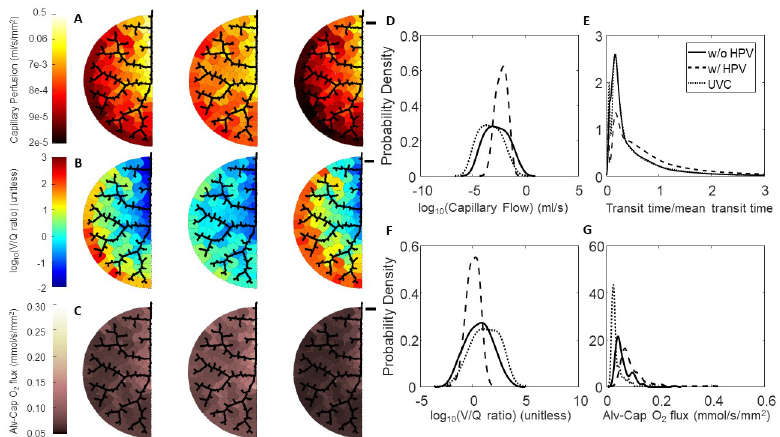
Fig 8. Effect of HPV and uniform vasoconstriction on Network C regional perfusion, V/Q matching, and oxygen flux. (A-C) Leftmost column of networks are without regulation from HPV, middle column of networks are with regulation from HPV, and the rightmost column of networks are with uniform vasoconstriction, where T � = 0.8 is used for the global vascular tone. The black scale bar is 1000 μ m. (A) Perfusion in the capillary compartments; (B) Ventilation-perfusion (V/Q) ratios in the capillary compartments; (C) Oxygen flux in the capillary compartments. (D-G) Blood flow, RBC transit times, V/Q ratios, and oxygen flux expressed as probability densities—calculated with a kernel density estimator. (D) Distribution of flow; (E) RBC transit times normalized to mean transit time; (F) Distribution of V/Q ratios; (G) Distribution of oxygen flux. https://doi.org/10.1371/journal.pcbi.1008861.g008 distribution of flow is very similar to the simulation run without regulation from HPV but slightly shifted to lower flows. This is graphically illustrated in Figs 6D, 7D and 8D and can also be understood by observing that the coefficient of variation for capillary blood flow decreases for all three networks (Table 5). Another way to interrogate the hemodynamic effects of HPV is to observe the red blood cell (RBC) transit time distribution. Experimentally, the RBC transit time distribution can be measured via an indicator-dilution experiment. In these experiments a vascular bed with a defined single inlet and outlet is identified. Then the inlet is then perfused with a bolus of tracer dye (ex: Evan’s Blue, FITC conjugated dextran), and then the washout is measured at the outlet [52]. The time series of tracer dye concentration at the inlet, C ( t ), and in